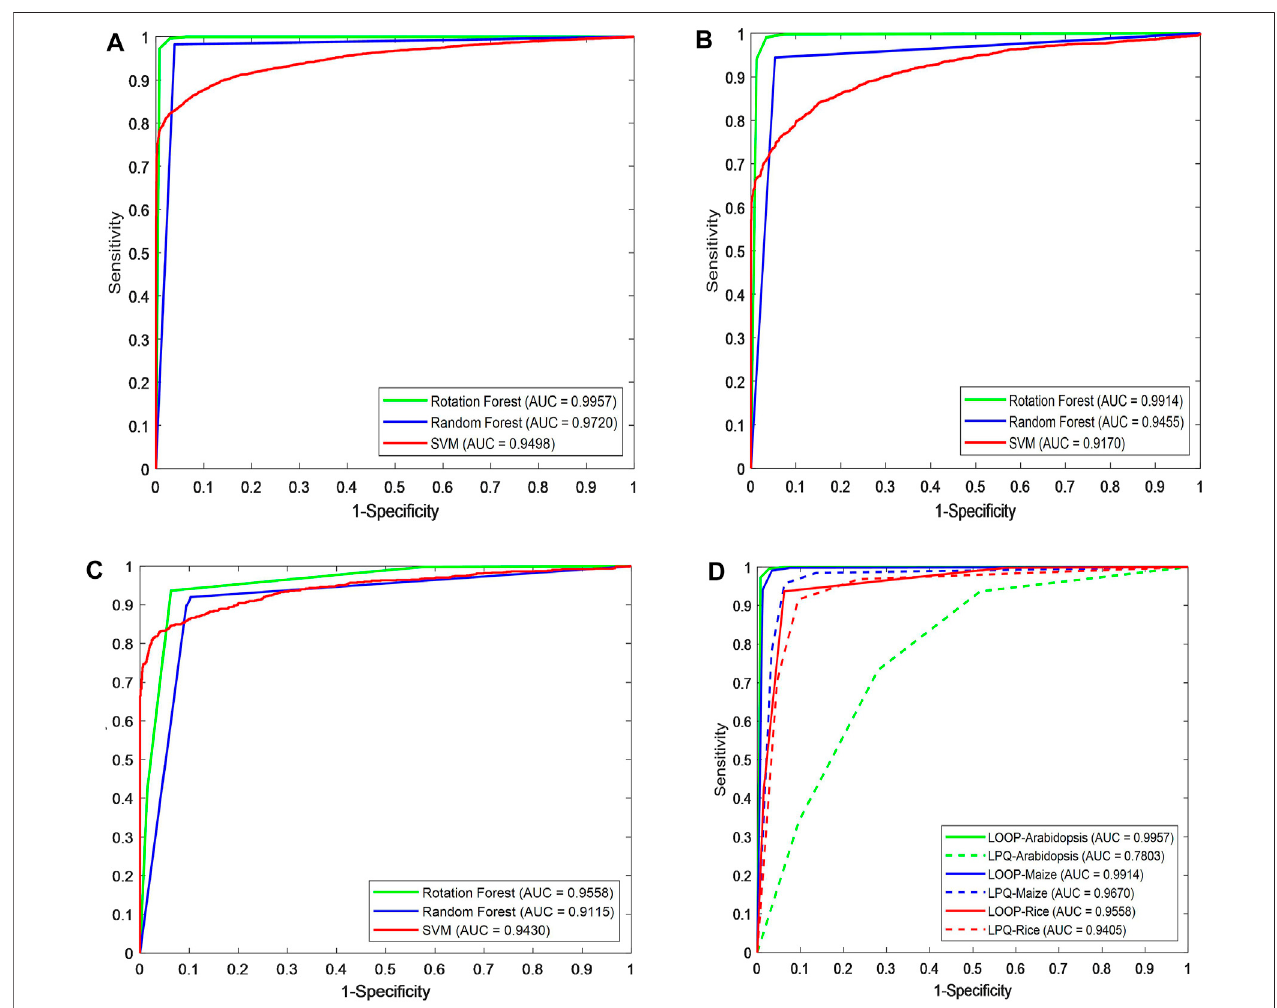
FIGURE 3 | Prediction performance comparison of different classi fi ers using ROC curves in predicting plant protein – protein interactions. Shown in the plot are the ROC curves for (A) Arabidopsis thaliana , (B) Zea mays , (C) Oryza sativa datasets using RF (blue line), ROF (green line), SVM (red line), respectively. (D) ROC curves of different descriptors on three plant PPIs datasets.